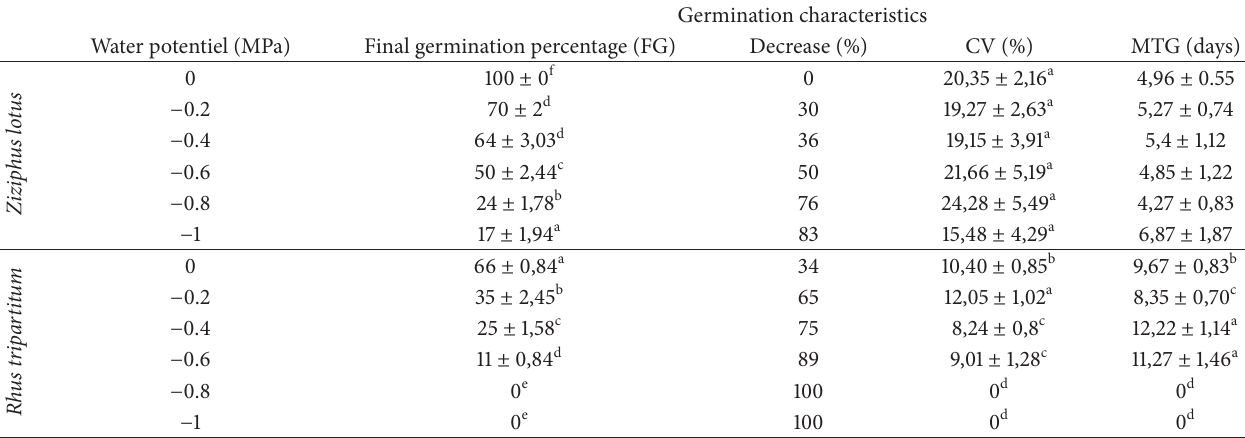
Table 3: Mean comparison (Duncan test 𝛼 = 0.05 ) of final percentage and mean time to germination of Ziziphus lotus (Z) and Rhus tripartitum (R) seeds under osmotic stress condition.